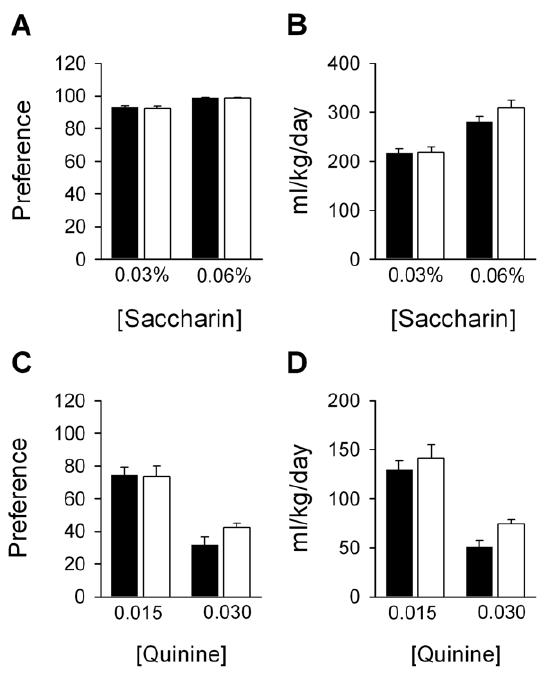
Figure 8. Taste preference is not altered in Lwt / + congenic mice. Relative to + / + littermates (n=14) (black bars), Lwt / + (n=13) (white bars) animals do not show differences in preference for (A) or consumption of (B) saccharin (%, w/v), or in preference for (C) or consumption of (D) quinine (units in mM). The same is true for the control strain (data not shown).